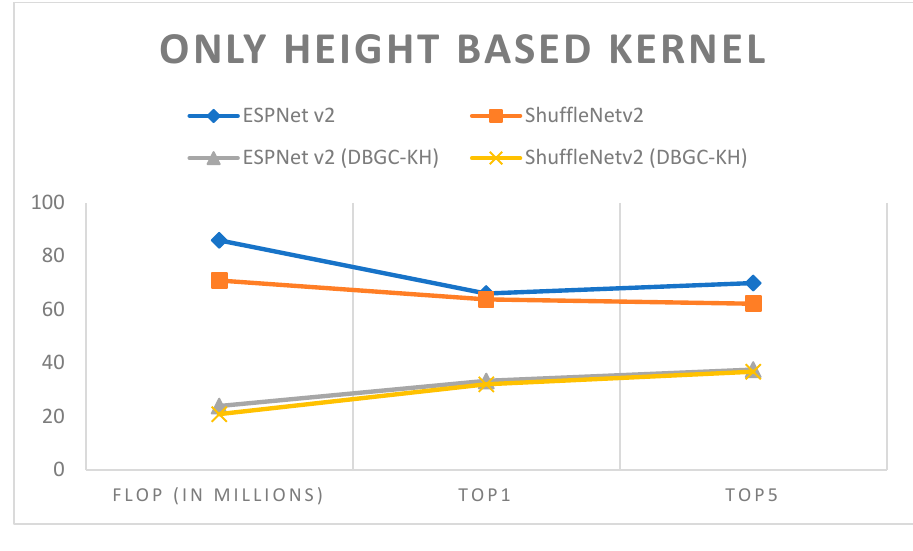
Figure 16. Only height-based kernel.